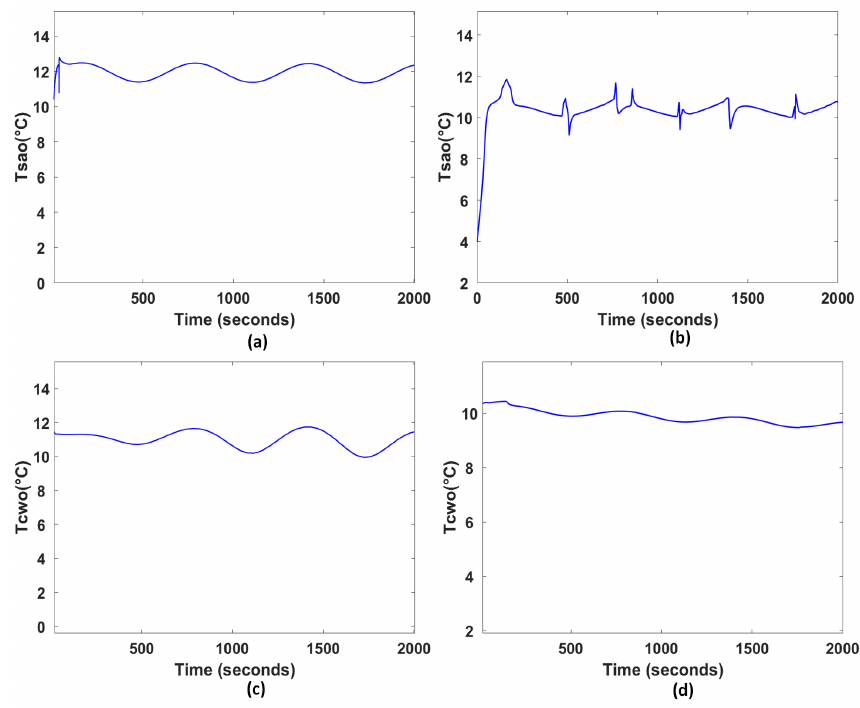
Figure 10. Output temperature results of, ( a ) supply air (Tsao) from the PID controller for the sine wave reference of Zone 1 and Zone 2, ( b ) supply air (Tsao) from SMC for the sine wave reference of Zone 1 and Zone 2, ( c ) cooling coil water outlet temperature (Tcwo) from the PID controller for the sine wave reference of Zone 1 and Zone 2 and ( d ) cooling coil water outlet temperature (Tcwo) from SMC for the sine wave reference of Zone 1 and Zone